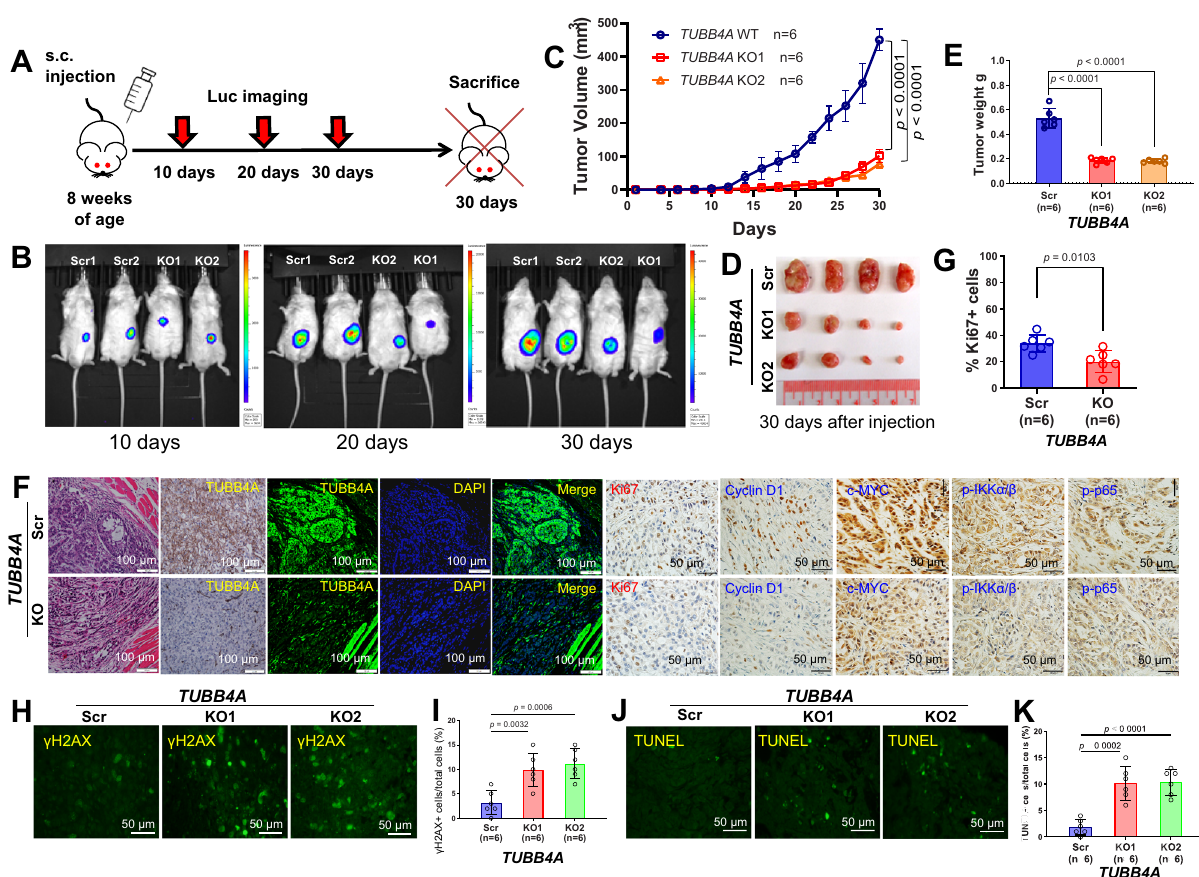
Fig. 6 TUBB4A KO reduces xenograft tumor growth in NSG mice. A Schematic diagram of S.C. xenograft tumors in NSG mice followed up to 30 days. B Luciferase imaging of xenografts after implantation. C Tumor volumes after injection ( n = 6/group). D , E Representative tumor masses and mean tumor weights on day 30. F H/E, IHC, and IF staining of xenograft tumors by speci fi c antibodies to TUBB4A, Ki67, cyclin D1, c-MYC, p-IKK α / β , and p-p65. Scale bar, 50 μ m or 100 μ m. G Statistical analysis of Ki67 + cells for scrambled and KO groups. H , I IF staining and statistical analysis of xenograft tumors by the DNA damage response marker γ H2AX. Scale bar, 50 μ m. J , K IF staining and statistical analysis of xenograft tumors by the apoptotic marker, TUNEL. Scale bar, 50 μ m. Data are replicated 6 times ( C , E , G , I , K ). Data are presented as the means and SD with a repeated measures ANOVA ( C ) or an ANOVA followed by Tukey ’ s post hoc t test ( E , I , K ) or a two-tailed t test ( G ). Source data are provided as a Source data fi le. Scr, scramble; KO, knockout; s.c., subcutaneous injection; luc,